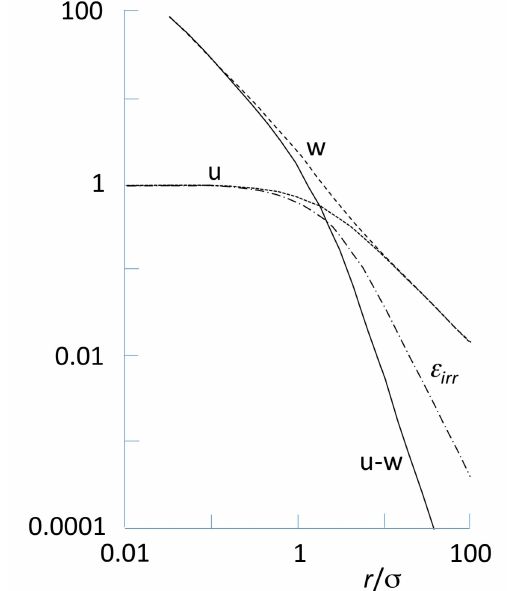
Fig. 3. u r , w r , u r - w r , and (cid:15) irr as functions of r/σ , for θ = 0 ; u r is indicated by short dashes, w r by long dashes, u r - w r by a solid line, and (cid:15) irr by dash-dot. All quantities are normalized so that the intracellular displacement and strain are equal to one at the